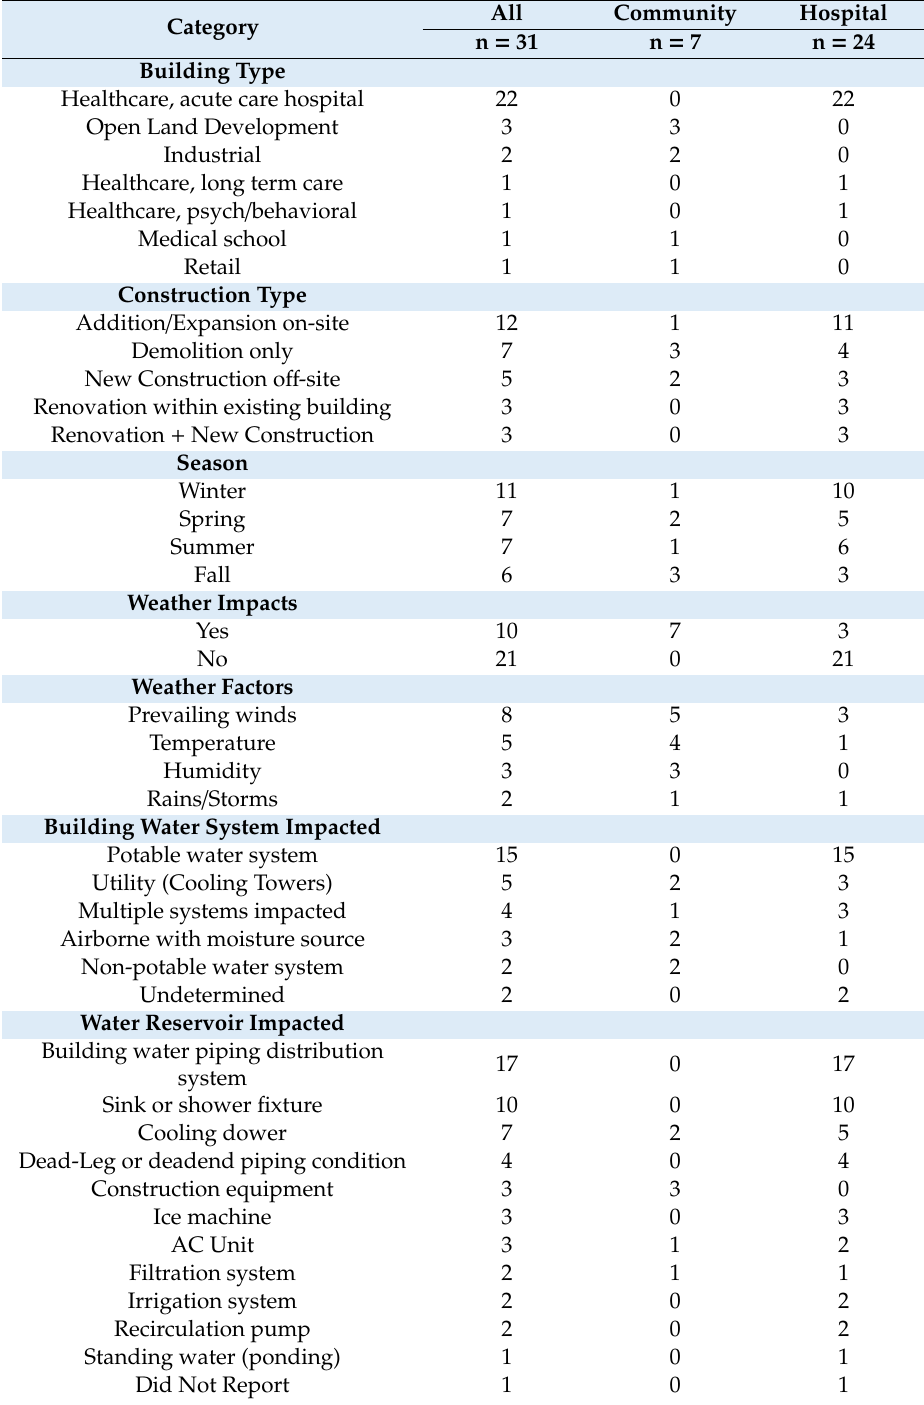
Table 4. Environmental and building